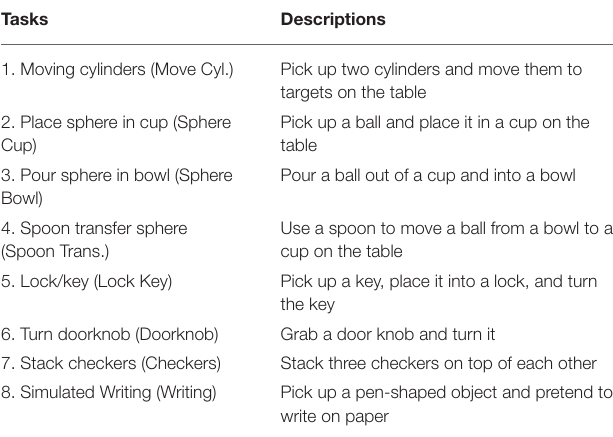
TABLE 1 | Description of the tasks and task name abbreviations.